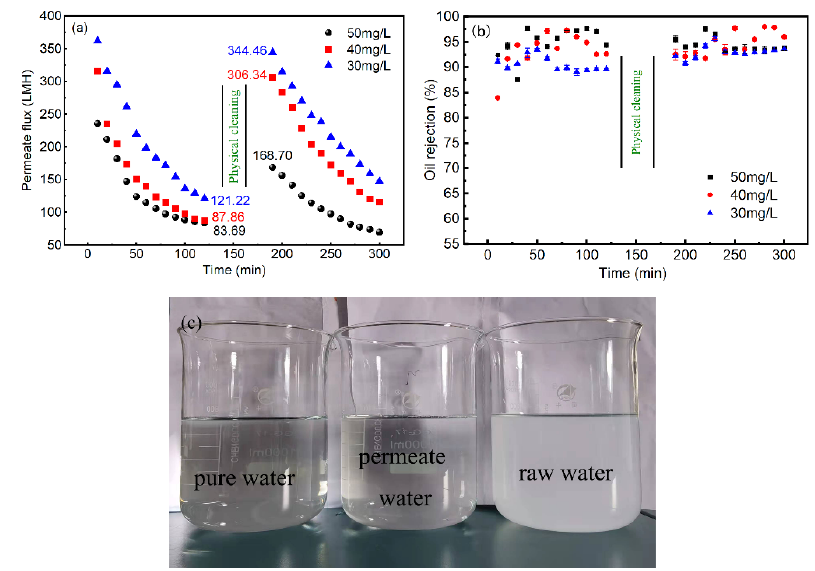
Figure 5. The separation performance of ACMs for oil in water emulsions, ( a ) permeability flux with time before and after physical cleaning; ( b ) the oil rejection rate of ACMs at different feed oil concentrations of 30–50 mg·L −1 ; ( c ) photograph comparison of raw water, permeate water and pure water. Table 2. Comparison of water flux and oil rejection between ACMs membrane and state-of-the-art ceramic membranes reported in literature.